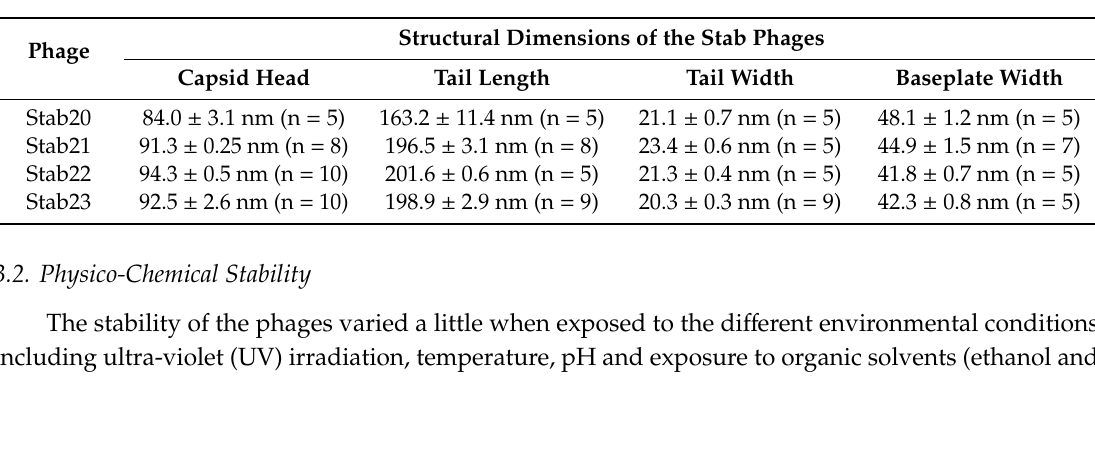
Figure 1. Transmission electron microscopy of phages Stab20, Stab21, Stab22, and Stab23. Uranyl acetate staining at original magnification of 25,000 × . Table 1. Dimensions of the Stab phage particles. The measurements were taken using the TEM-camera inbuilt software at a magnification of ×